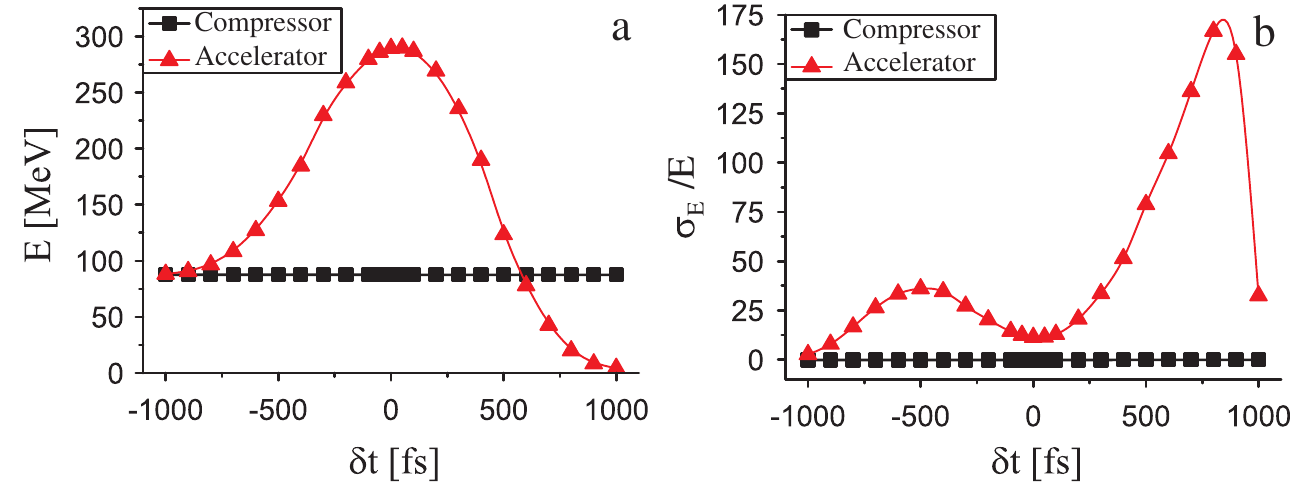
FIG. 5. (Color) Effect of fluctuations in the timing between laser and electron bunch on the energy (a) and energy spread (b) for both the compressor and accelerator